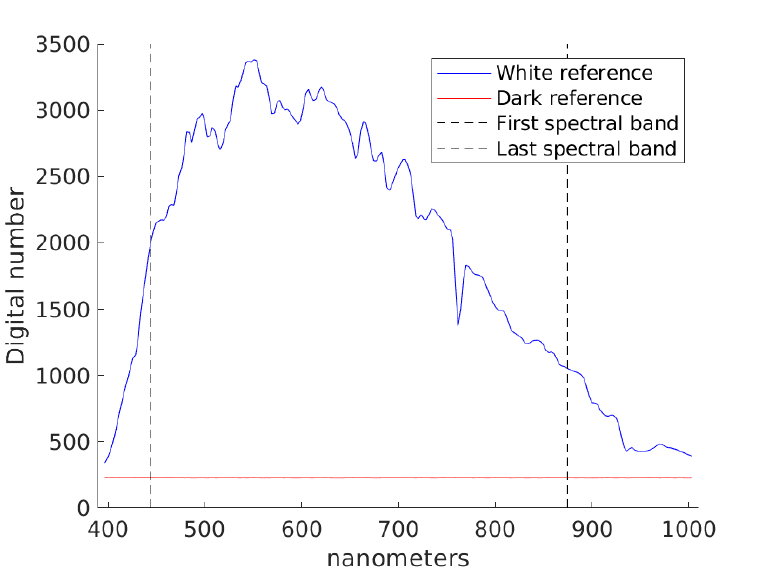
Figure 2. Spectral response of the Specim FX10 hyperspectral camera. The range of wavelengths collected by the data set employed in this manuscript is enclosed between dashed